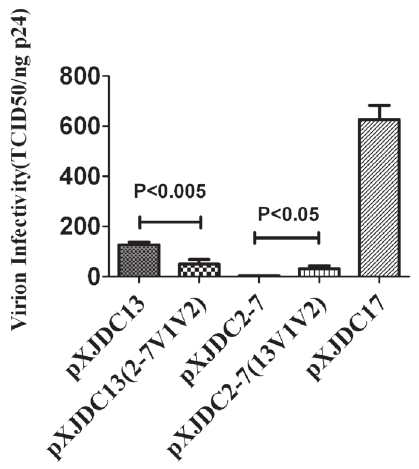
Figure 6. Measurement of infectivity of clone-derived viruses. The clone-derived virus was produced by transfection into 293T cells and stored at 2 80 u C. Frozen virus supernatant was then thawed to test the TCID 50 value on Tzm-bl cells and p24 antigen levels. Virion infectivity was calculated by TCID 50 /ng p24. The mean values are shown with standard deviations from three separate assays.